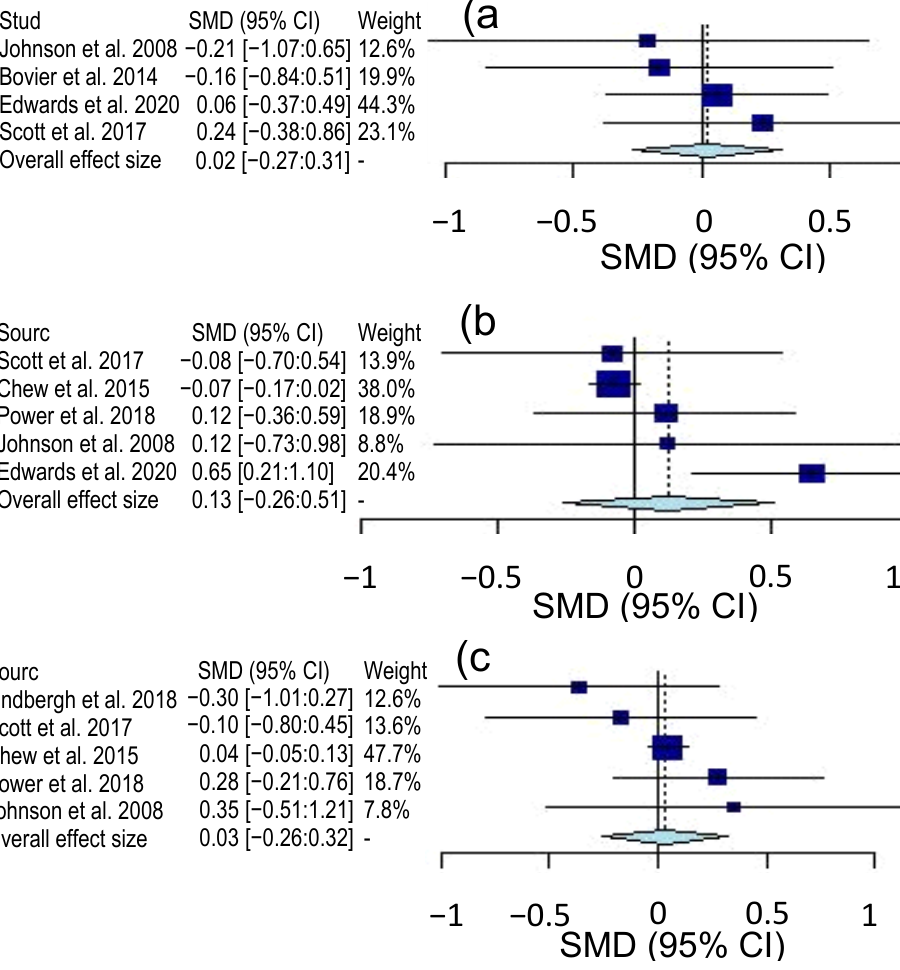
Figure 3. Forest plots of cognitive domains: ( a ) complex attention, ( b ) executive function and ( c ) memory. All plots express effect size as Hedge’s g SMD with 95% confidence interval and study